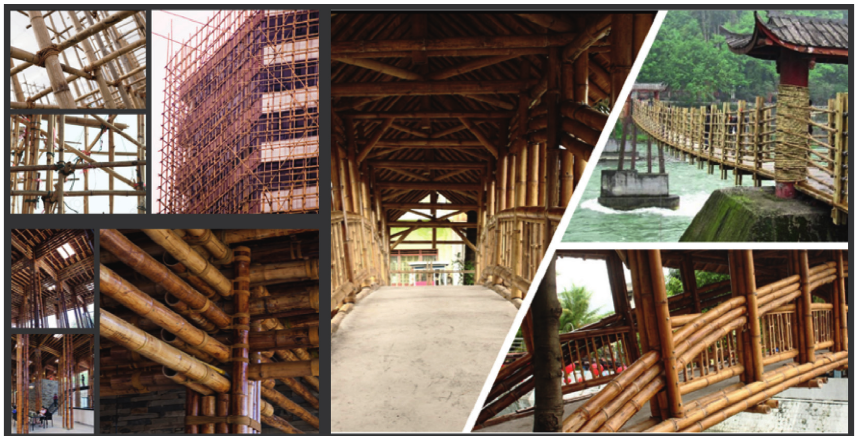
Figure 1: Bamboo as a structural element.